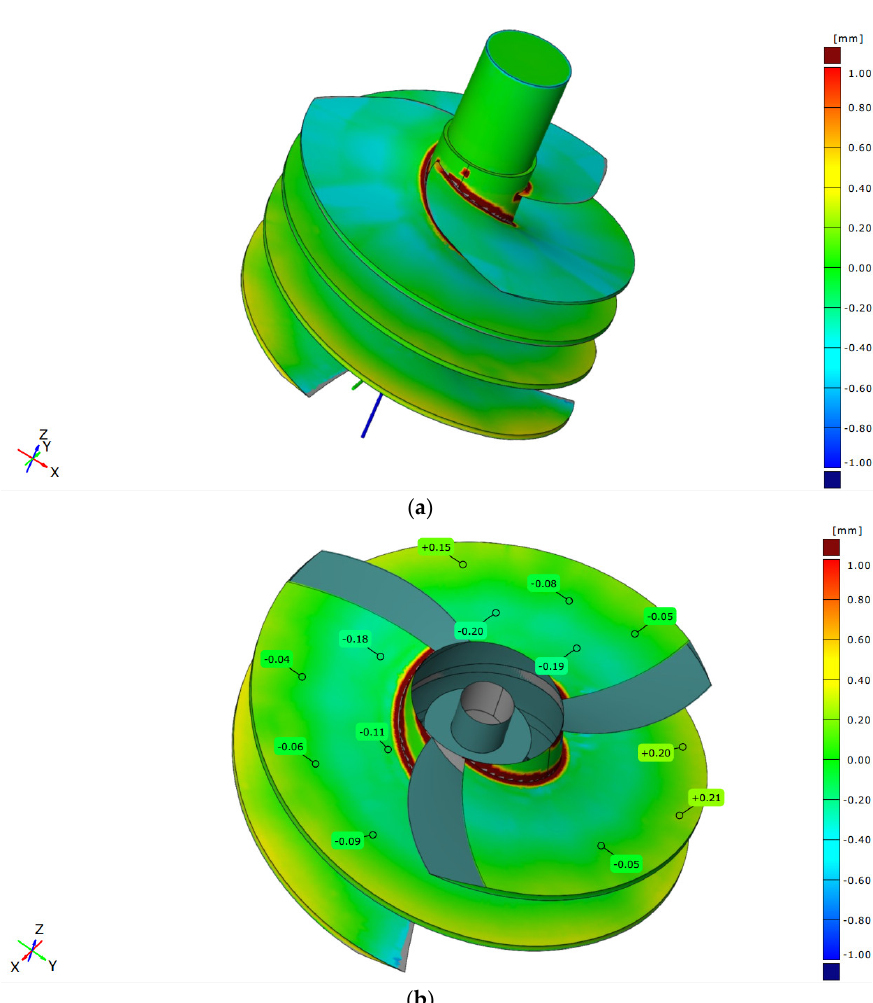
Figure 10. Machining accuracy measurement: ( a ) 3D model; ( b ) measurement results.